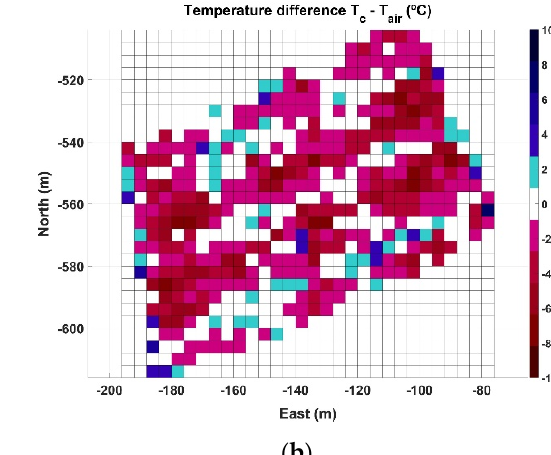
Figure 12. Grid maps for Map B: ( a ) spatial distribution of NDVI; and ( b ) ∆ T (°C).